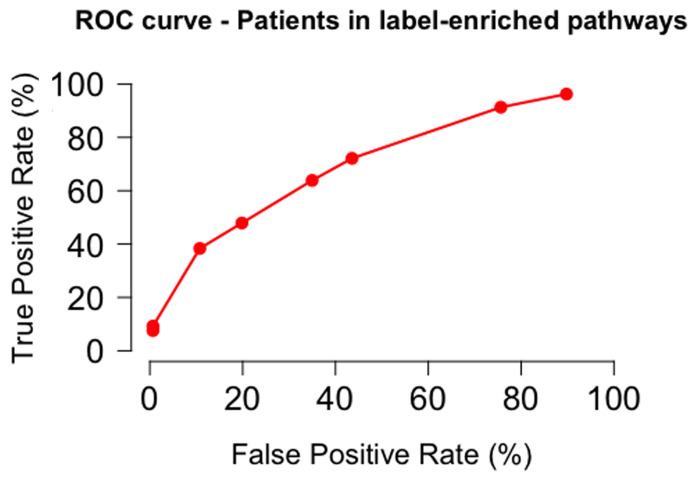
ROC curve for case-control classification in autism, using rare copy number variations (CNV) in pathway genes.In this design, patients are classified as cases if they carry a CNV in pathways passing feature selection, and controls otherwise. Each dot in the graph shows the sensitivity/specificity for a given cutoff for feature selection.